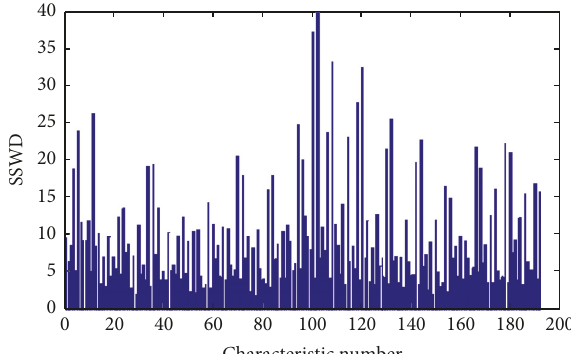
Figure 8: The SSWD of 192 statistical characteristics of the training samples.